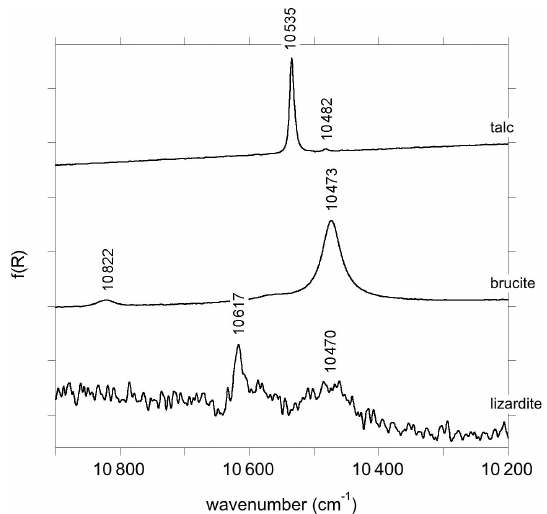
Figure 2. Second overtone OH stretching spectra of talc, brucite and